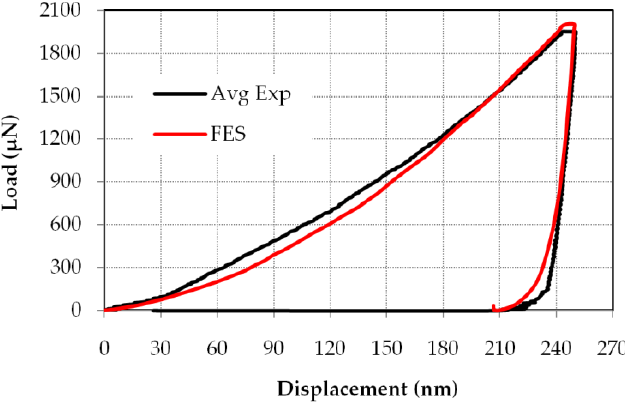
Figure 8. Experimental and simulation results of the load/unload-displacement response of aluminum 1100 during the nanoindentation